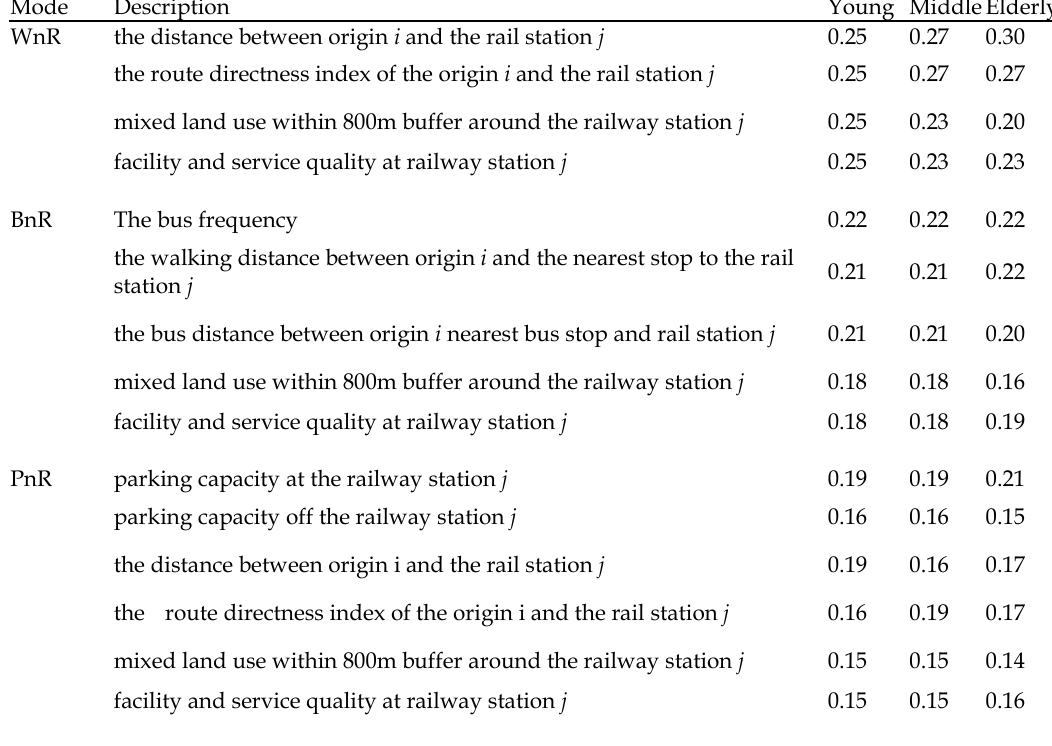
Table 5. The weights of